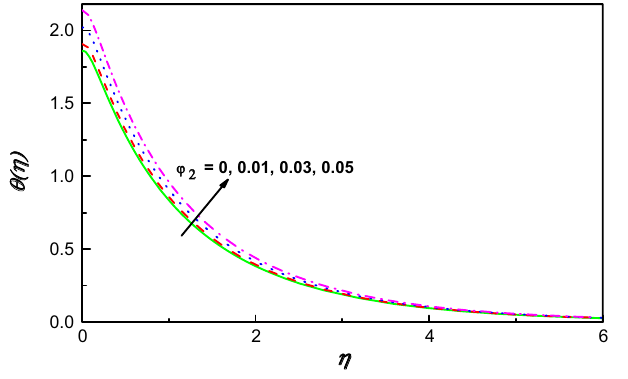
Figure 12. θ(η) variation vs. ϕ 2 .